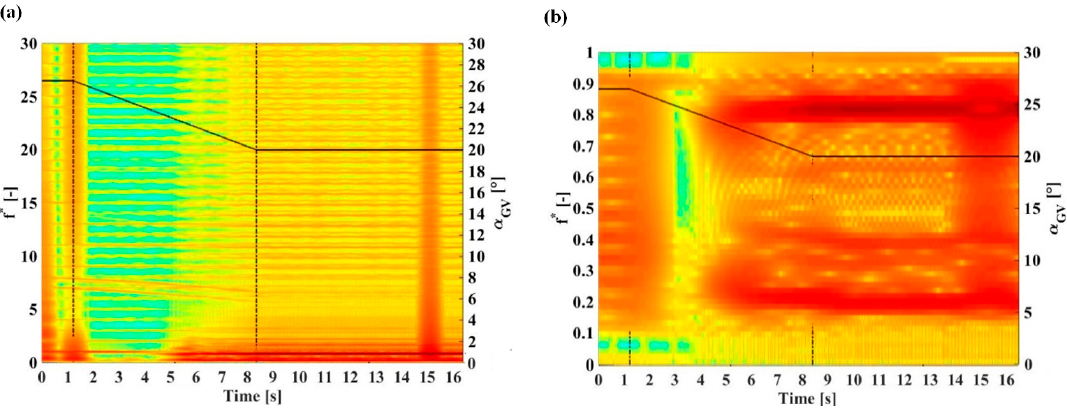
Figure 16. Spectrograms of the pressure monitor PS1 (runner blade, pressure side). ( a ) Full spectrum. ( b ) Low-frequency spectrum. The black solid line represents the guide vanes angle with the y-scale to the right. The dotted vertical lines represent the start and the end of the guide vane closure.